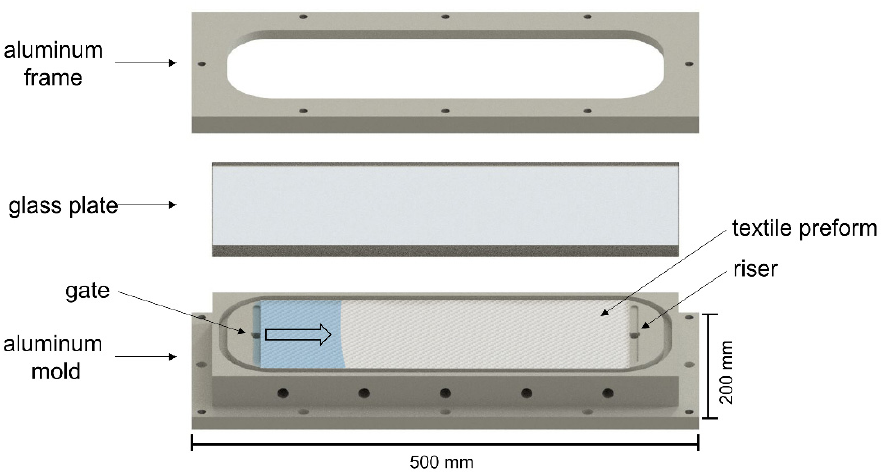
Figure 4. Experimental setup to produce planar test specimens with a photoreactive resin system.